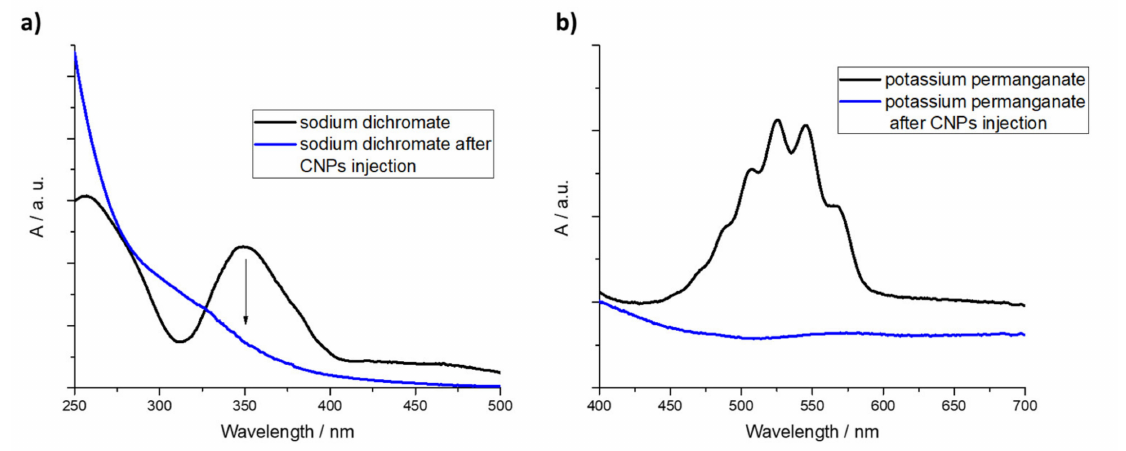
Figure 5. Spectroscopic evidence of the effect induced by CNPs on ( a ) dichromate and ( b ) permanganate